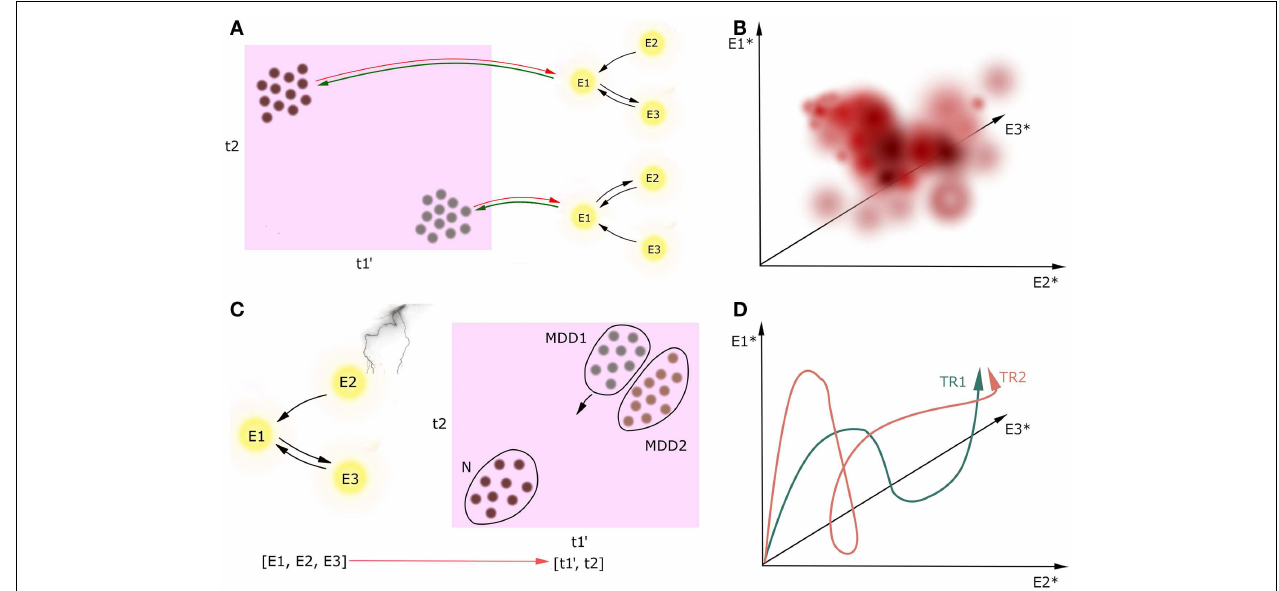
represent, i.e., level of mood) in a three-dimensional space spanned by the attractors of the underlying three-node network.Thirdly, one can track the current state of one patient both in the multidimensional construct space during the treatment [ (C) , a scatter plot in case we want to track multiple patients at a time]. Distribution of patients in this space may reveal subtypes of MDD (MDD1, MDD2). Moreover, when the network manipulation with treatment is sufficient, it can trigger the patient’s brain state toward a new attractor in some of the construct-related dimensions, and in a result the patient flows to another point in the construct space. Since we will create these maps on the data from the limited number of patients in the cohort, this temperature maps will not span the whole volume of possibilities. Lastly, one may investigate how the treatmentsTR i affect the attractors of the underlying networks (D) . In this case, we have three nodes in the underlying networks, which means that the attractors of this system will be points in a three-dimensional attractor